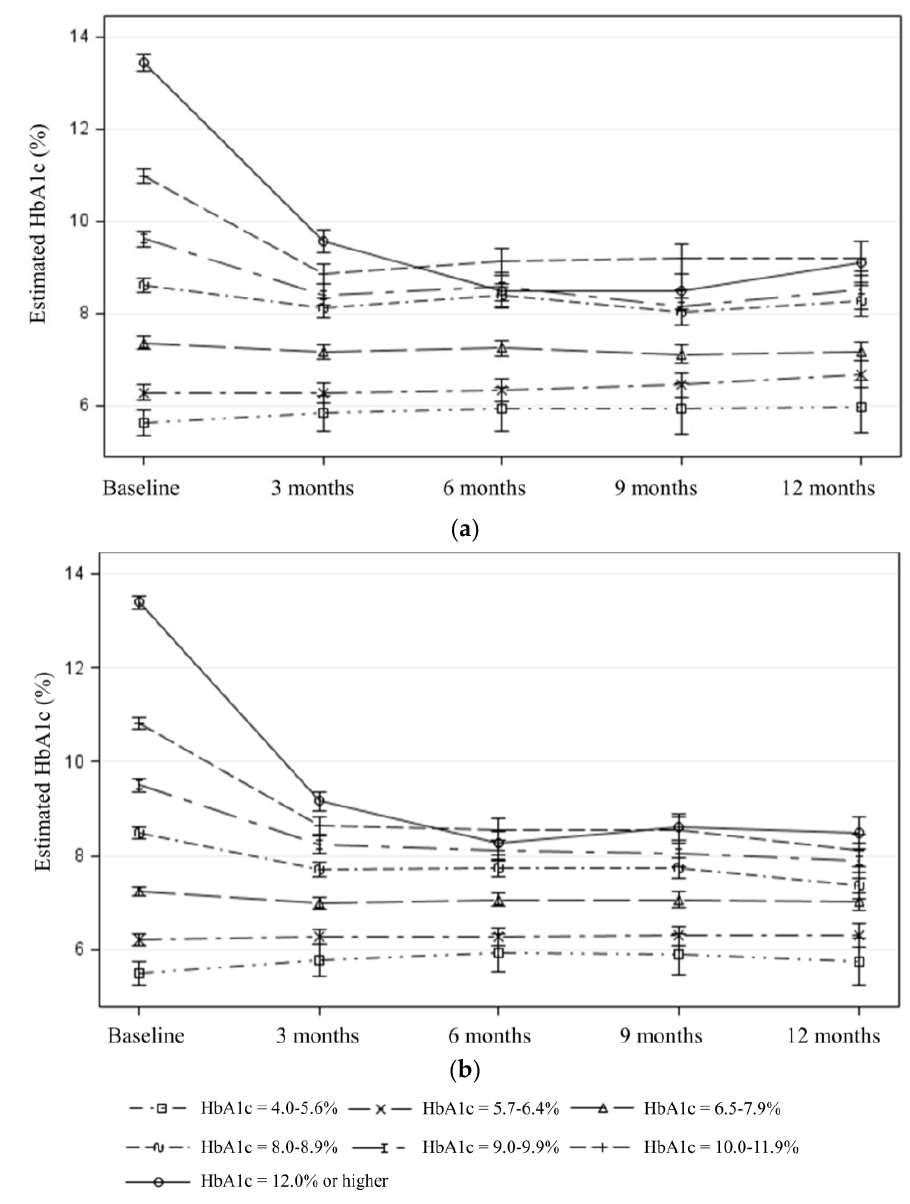
Figure 3. Estimated changes in A1c level from baseline to 3-, 6-, 9-, and 12-month follow-up among those with Type 2 diabetes after adjusting for age, gender, ethnicity, education, language, and baseline BMI category, by baseline A1c and biennia: ( a ) first biennium; ( b ) second biennium. A1c, average blood glucose level over the past 3 months. BMI, body mass